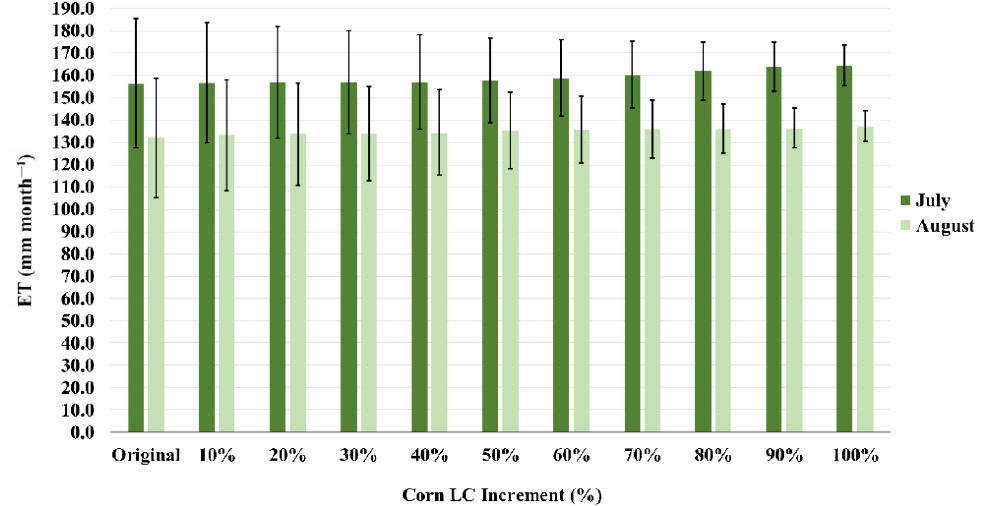
Figure 12. BEPS-generated monthly ET rate (mm month − 1 ) for July and August under different per- centages of corn cover.